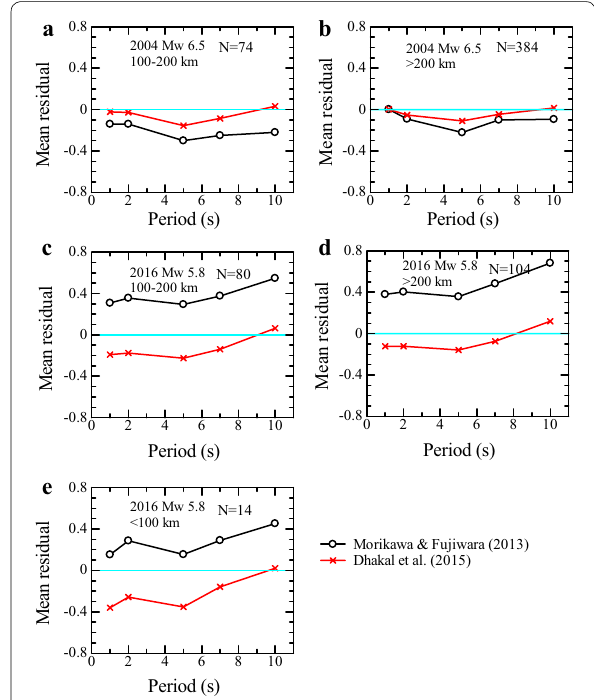
Fig. 13 Mean residuals as a function of period and distance for the 2004 Mw 6.5 and 2016 Mw 5.8 events. The black line with circles and red line with diagonal crosses denote the mean residuals on a base-10 log-scale with respect to the GMPEs of Morikawa and Fujiwara (2013) and Dhakal et al. (2015), respectively. a 2004 event for distances between 100 and 200 km. b 2004 event for distances larger than 200 km. c 2016 event for distances between 100 and 200 km. d 2016 event for distances larger than 200 km. e 2016 event for distances smaller than 100 km. The number of data points used in the analysis is denoted by the letter N in each